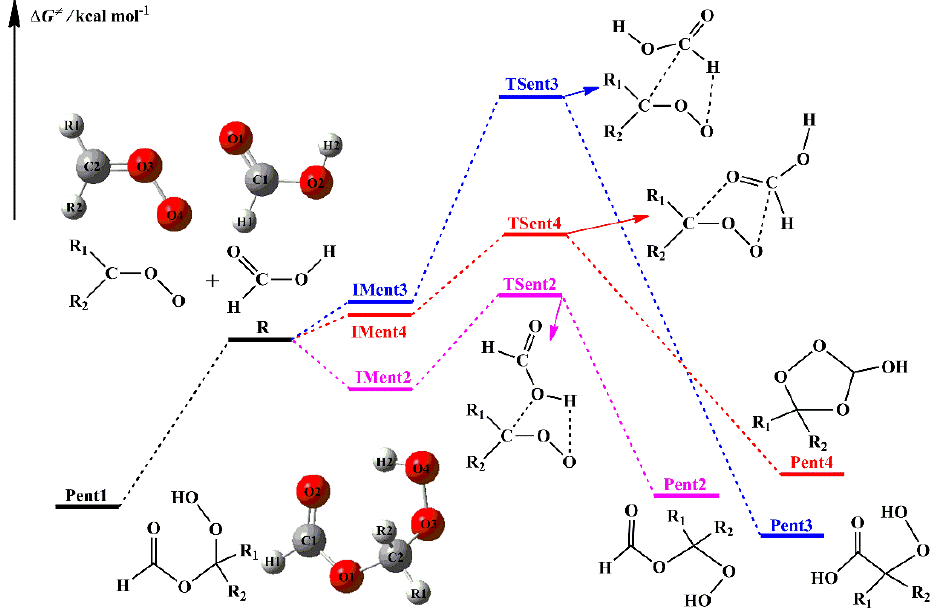
Figure 1. Schematic PES for the possible entrance pathways of the initiation reactions of HCOOH with various SCIs (black, pink, blue, and red lines represent the 1,4 O-H insertion, 1,2 O-H insertion, C-H insertion, and C = O cycloaddition reactions,